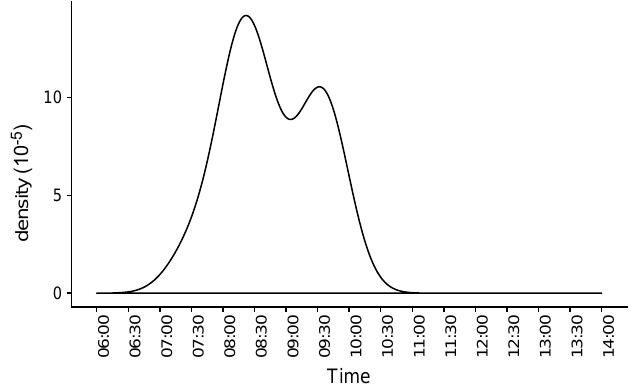
Figure 5. Frequency of room ventilation based on the opening of the window.